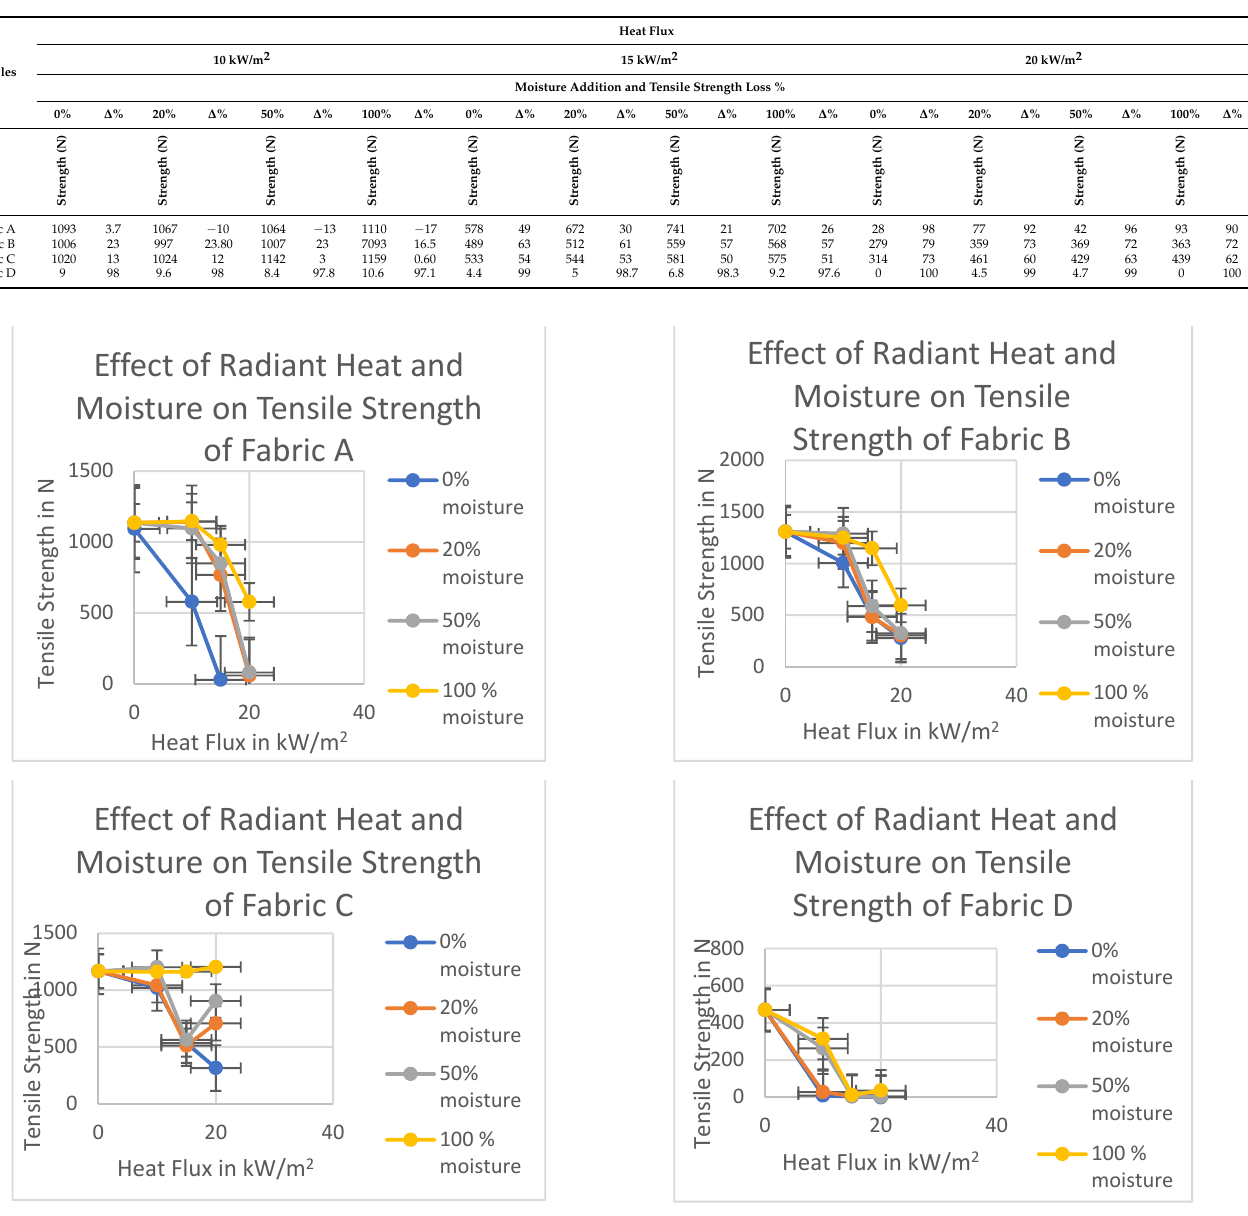
Figure 8. Effect of radiant heat and moisture on tensile strength of the outer layer fabrics in multi- layered fabric system .